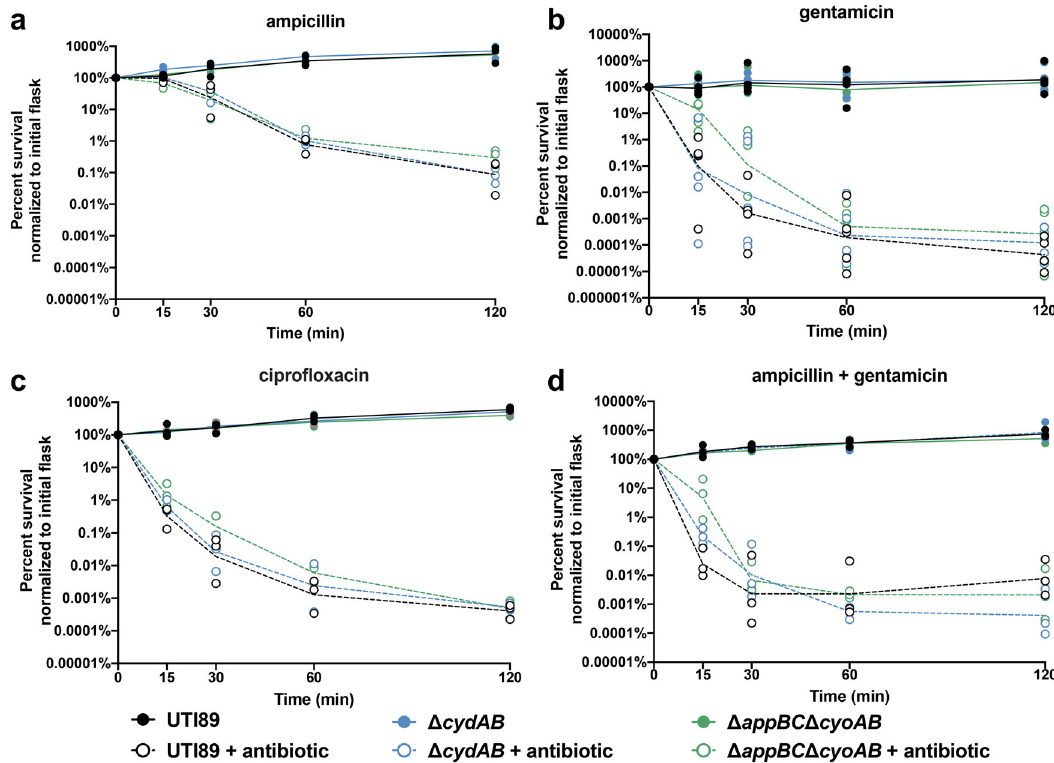
Fig. 3 Cytochrome bd does not affect the rate of antibiotic-induced cell death in planktonic cells. a – d Time kill kinetics assays were performed to evaluate the susceptibility of UTI89 (black), Δ cydAB (blue), and Δ appBC Δ cyoAB (green) to ampicillin ( a ), gentamicin ( b ), cipro fl oxacin ( c ), or a combination of ampicillin and gentamicin ( d ) at 5x MIC. Data were analyzed by a two-way ANOVA with Tukey ’ s multiple comparisons test and determined to have no signi fi cant differences between strains. Data are representative of at least three biological replicates. Lines connect geometric mean at each time point. Each dot represents a biological replicate.